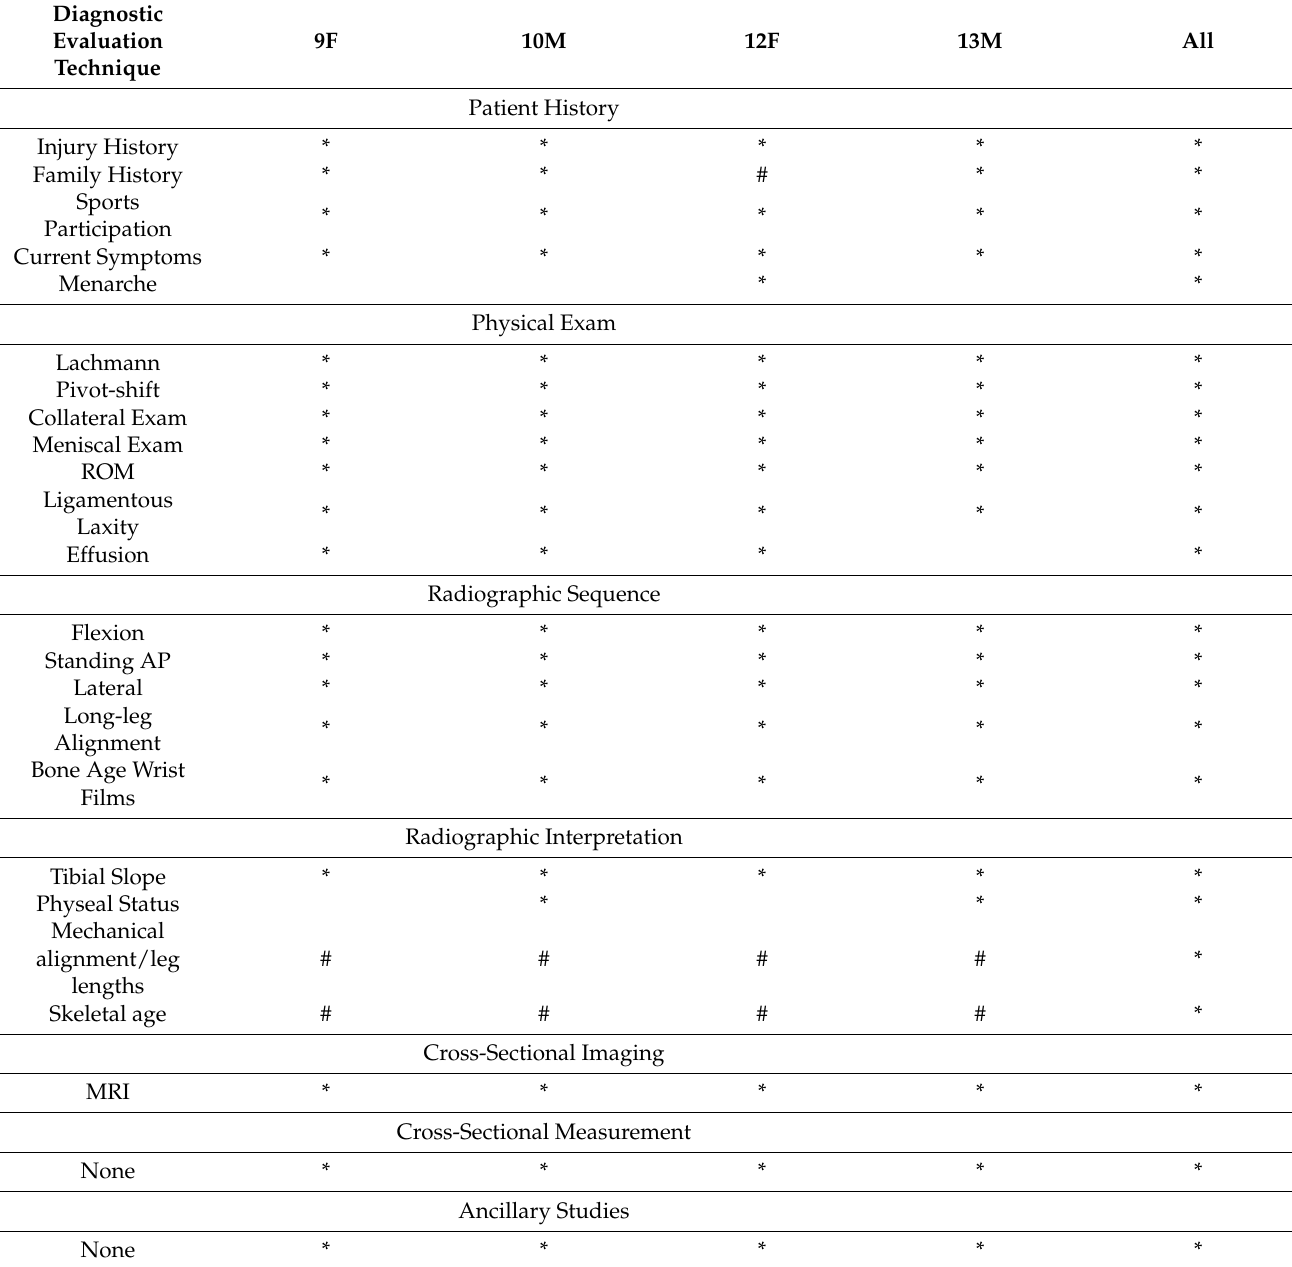
Table 4. Summative Delphi results with agreement (* ≥ 66%) responses and topic of controversy (#). The final column presents our proposed standardized diagnostic pathway for patients with pediatric ACL